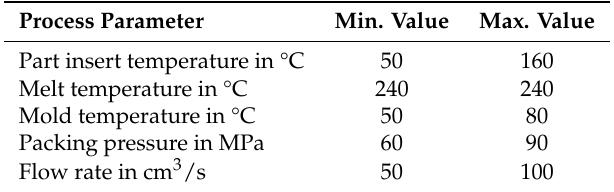
Table 2. Process parameters used for the manufacturing of cross tension